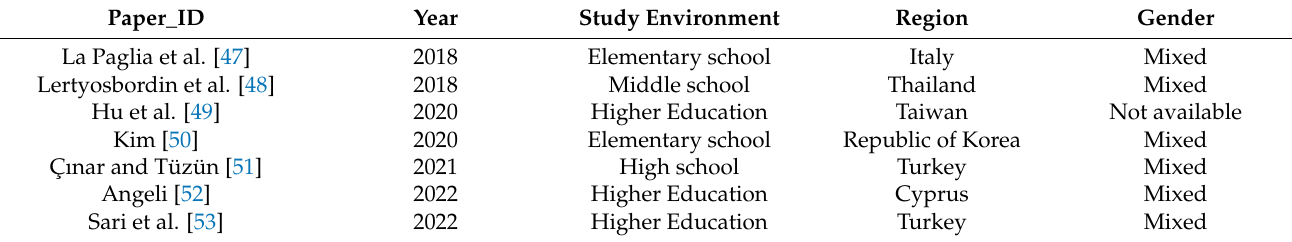
Table 4. Study context characteristics.